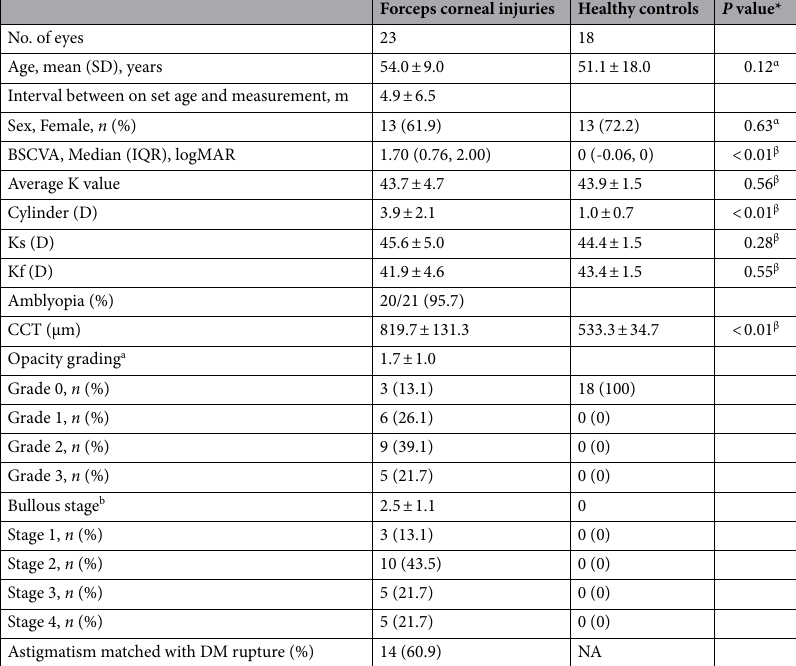
Table 1. Patient demographics. BSCVA, best-spectacle corrected visual acuity; CCT, central corneal thickness; DM, Descemet’s membrane; IQR, interquartile range; logMAR, logarithm of minimal angle resolution. a Corneal opacity grade; 0, clear or trace haze; grade 1, mild opacity; grade 2, moderately dense opacity partially obscuring the details of the iris; and grade 3, severely dense opacity obscuring the details of the intraocular structures. b The severity of bullous keratopathy was defined as follows: stage 1, slight stromal edema or increased corneal thickness due to reduction in corneal endothelial cells; stage 2, stromal edema with DM folds; stage 3, stromal edema and DM folds with apparent epithelial bullae; stage 4, stromal scarring and corneal neovascularization. α P values: Pearson’s chi-square test, β P values: Mann–Whitney